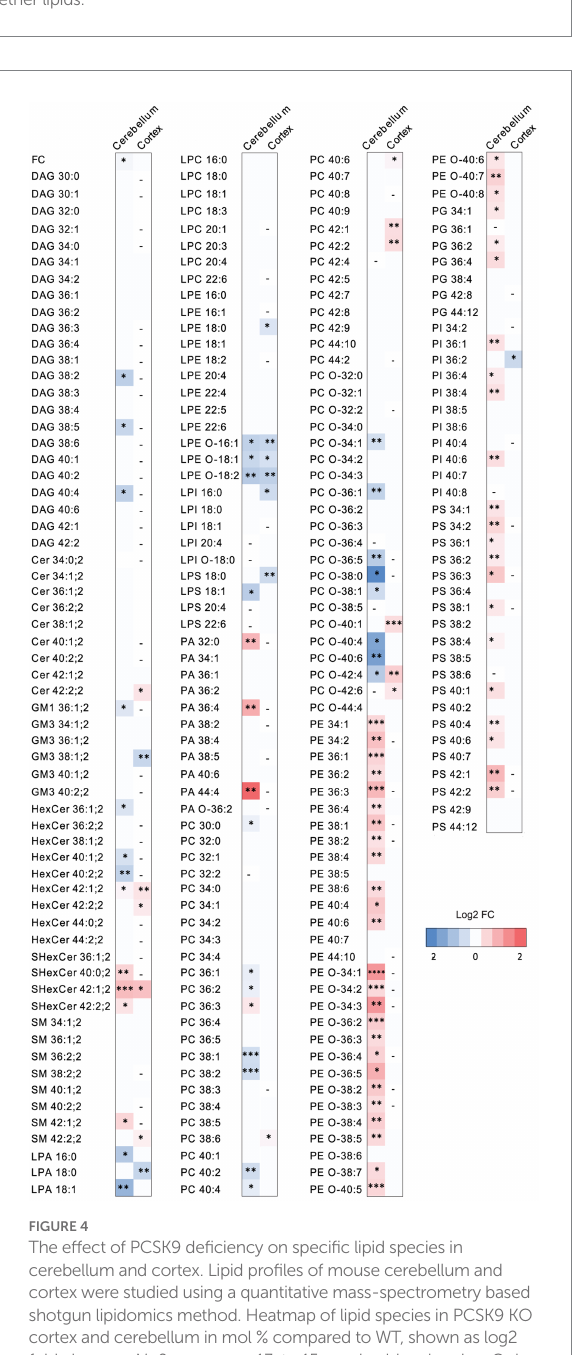
FIGURE 3 (Continued) PCSK9 KO cerebellum and cortex. Data are represented as mean ± SEM. (E) Heatmap of different lipid classes in PCSK9 KO cortex and cerebellum in mol % compared to WT, shown as log2 fold changes. (F–I) Volcano plots representing the significantly up- and down-regulated lipid classes and species in cerebellum (F,G) and cortex (H, I) . N = 9 per group; 13-to 15-week-old male mice. Only statistically significant results showed. Statistical significance was assessed using unpaired two-tailed Student’s t test, alpha = 0.05. See also Tables 1 , 2 for descriptive statistics and individual p